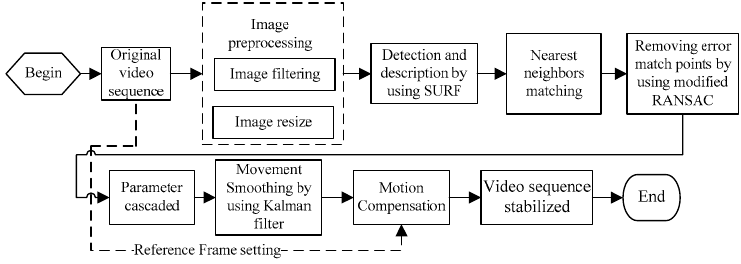
Figure 11. Application of the stabilization method.